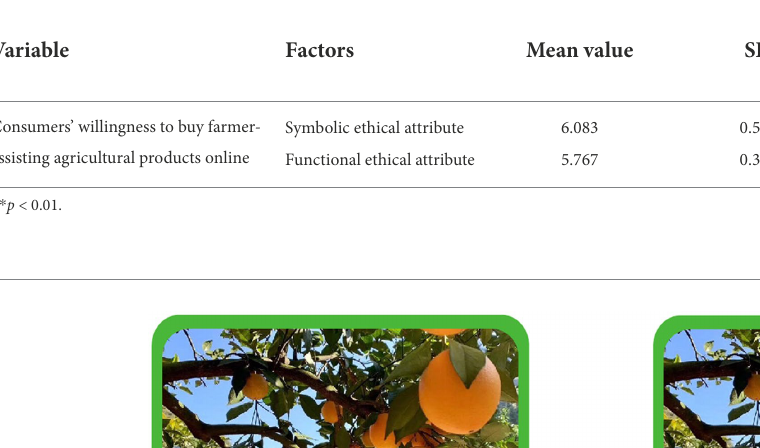
TABLE 4 Results of independent samples t -test.